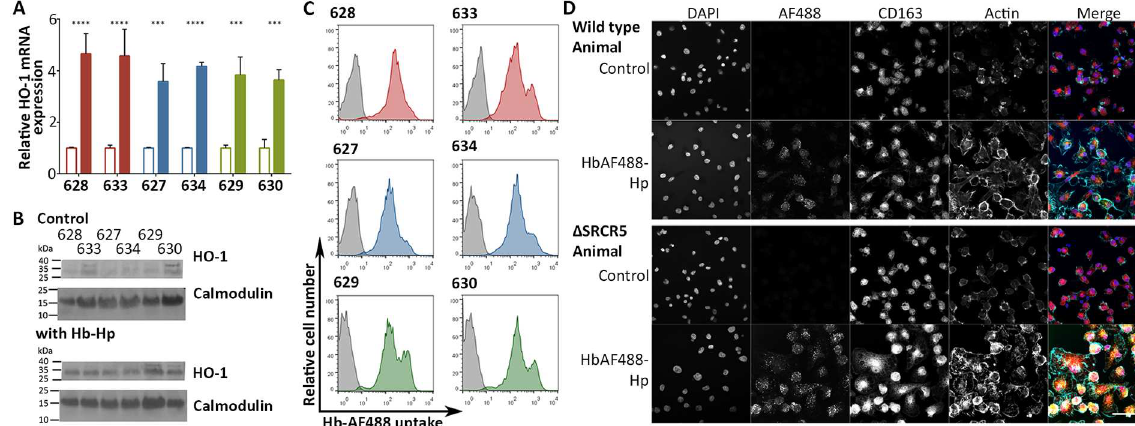
Fig 8. Δ SRCRperipheral blood monocyte-derived macrophages (PMMs) still function as hemoglobin-haptoglobin (Hb-Hp) scavengers. A) Inductionof HO-1 expressionby Hb-Hp uptake. PMMs were incubatedfor 24 h in presenceof 100 μ g/ml Hb-Hp. RNA was isolatedfrom cells and levels of heme oxygenase 1 (HO-1) mRNA determined by RT-qPCR (outlinedbars uninduced, filled bars Hb-Hp uptake induced; red wild type, blue heterozygous, green Δ SRCR5). Expression levels were normalized using β -Actin expressionlevels and to the level of unstimulated HO-1 mRNA expressionof each animal. Uninducedversus inducedlevels of HO-1 expressionwere analyzedby an unpairedt-test. Error bars represent SEM, n = 3. B ) PMMs were incubatedfor 24 h in presence of 100 μ g/mol Hb-Hp. PMMs were lysed with reducing SDS sample buffer and HO-1 protein expressionanalyzedby western blot. C ) Quantification of Hb-Hp uptake. PMMs were incubatedin presenceof 10 μ g/ml Hb AF488 -Hp for 30 min. Uptake of Hb AF488 -Hp was measuredby FACS analysis(coloredcontour plots; red wild type, blue heterozygous, green Δ SRCR5) relative to isotype controls (grey). D) Visualizationof Hb-Hp uptake. PMMs were incubatedfor 30 min with 10 μ g/ml Hb AF488 -Hp. Cells were fixed, permeabilized and stainedagainstCD163 and with DAPI. Representatively shown are pig 628 as wild type and 630 as Δ SRCR5animals. Scale bar represents 40 μ m.